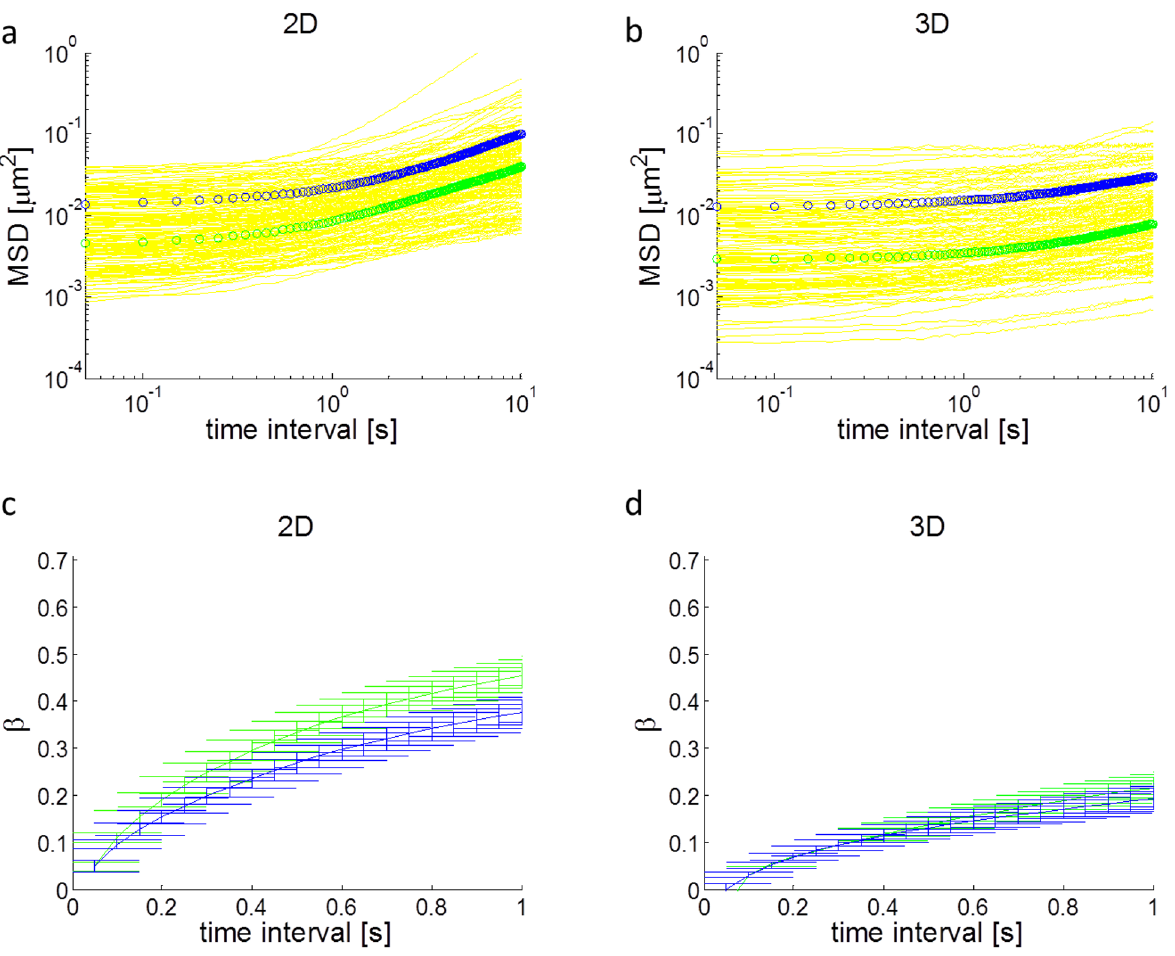
Figure 3. Intracellular fluctuations in 2D vs. 3D. a,b) 1D mitochondria MSDs in the two orthogonal directions with maximum ratio in displacement fluctuations for cells in (a) 2D and (b) 3D. Larger slopes (more fluid-like behavior) and magnitudes are exhibited by cells in 2D at longer time intervals. c,d) Logarithmic time derivative b of MSDs for cells in (c) 2D and (d) 3D in the corresponding 1D directions. Cells in 3D have lower b ’s, indicating more solid-like behavior. Error bars are s.e.m. The color code of the curves is the same as in Figure